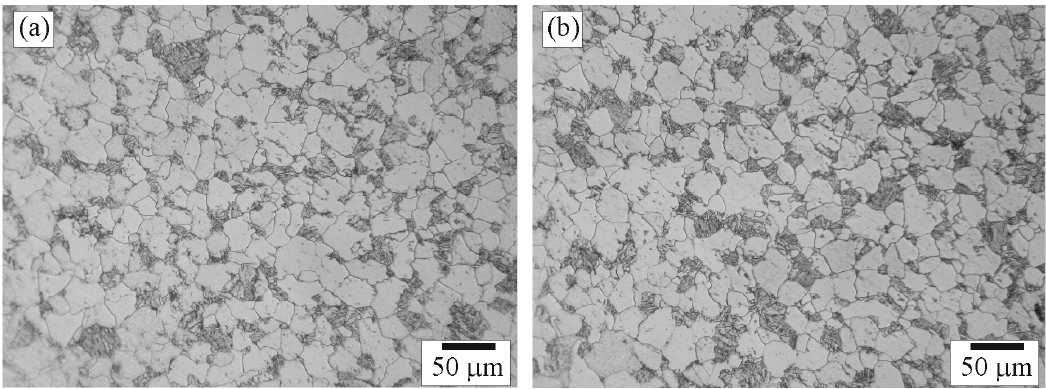
Figure 4. Optical micrographs of positions: ( a ) Aa; and ( b ) Ab in Zone A.